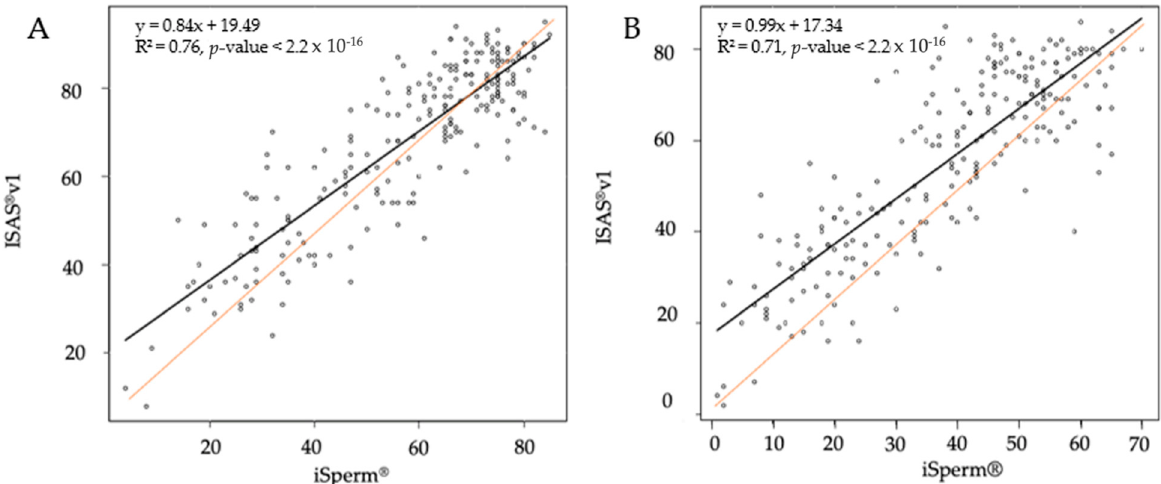
Figure 3. Linear regressions for total motility ( A ) and progressive motility ( B ) between the ISAS ® v1 and the iSperm ® based on the average of four fields captured by both devices.